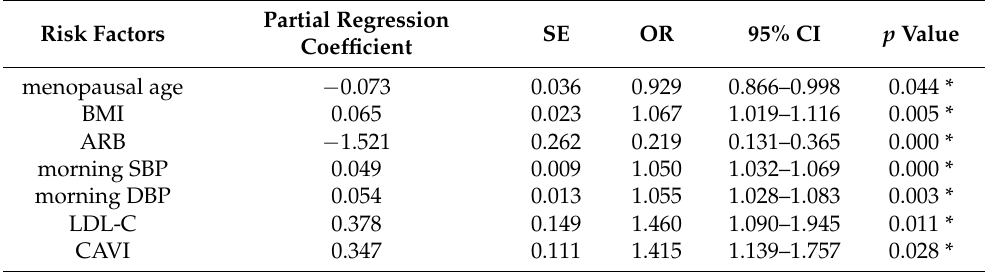
Table 3. Logistic regression analysis of the risk of left ventricular hypertrophy in patients with postmenopausal